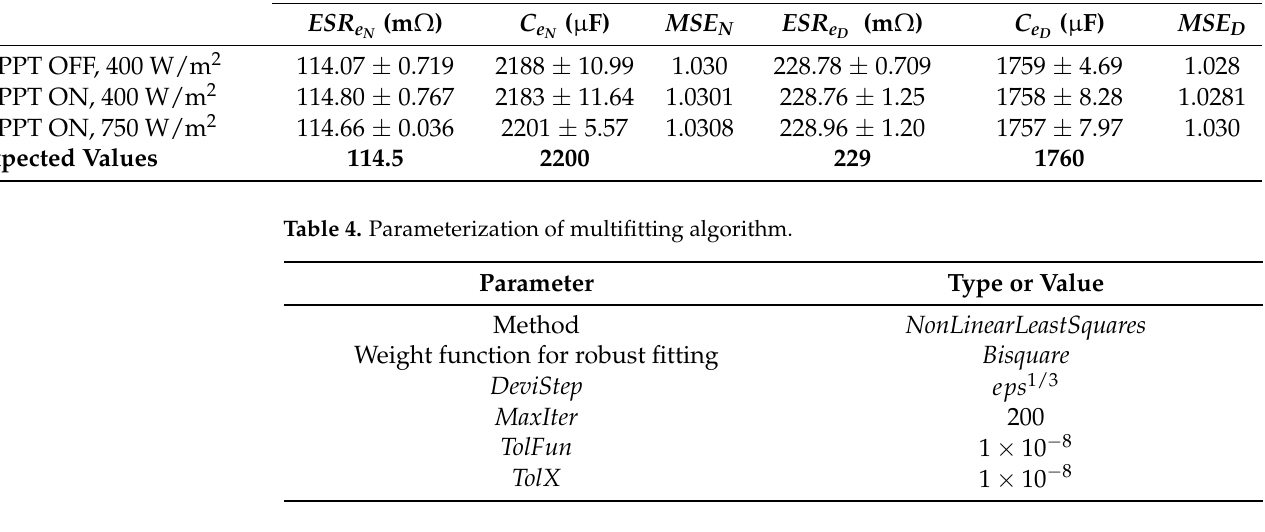
Table 3, it results that the mean square error ( MSE ) of the fitting process was close to 1; so,